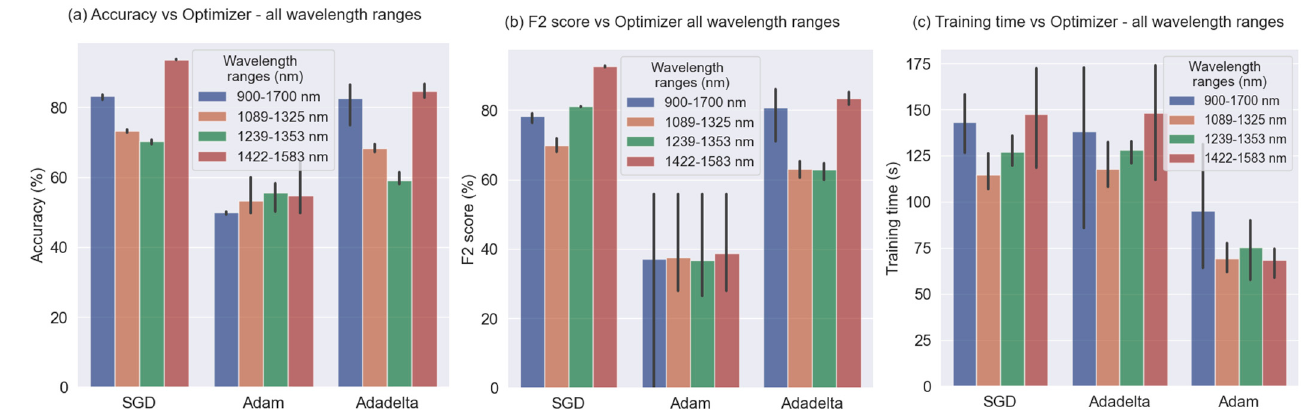
Figure 9. Accuracy, F2 ‐ Score, and Training time vs. Optimizer.